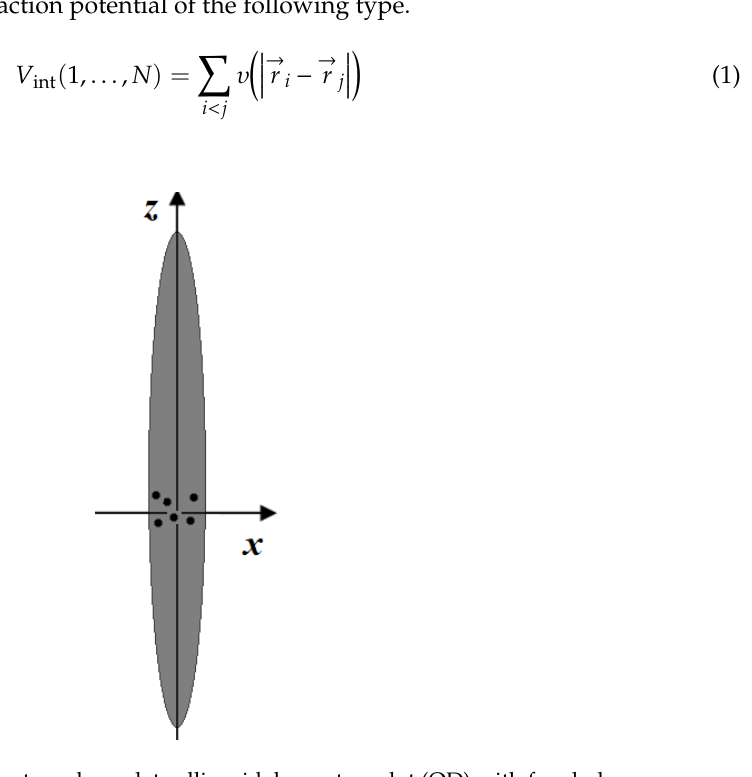
Figure 1. Cross-section of the strongly prolate ellipsoidal quantum dot (QD) with few-hole gas.